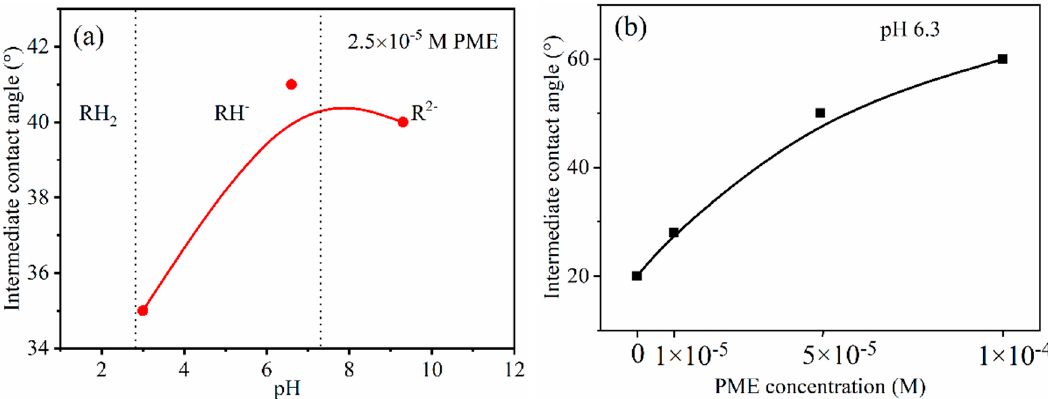
Figure 1. Intermediate contact angle of barite with lauryl phosphate (PME) as a function of pH ( a ) and concentration ( b ).